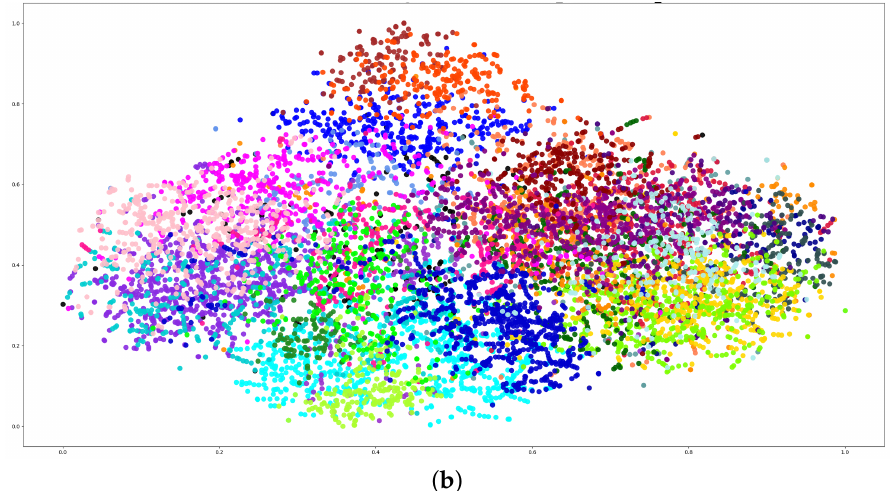
Figure 5. The total number of frames is 10,000; the above figure ( a ) is the feature distribution before training with PPL loss, and the following figure ( b ) is the feature distribution after